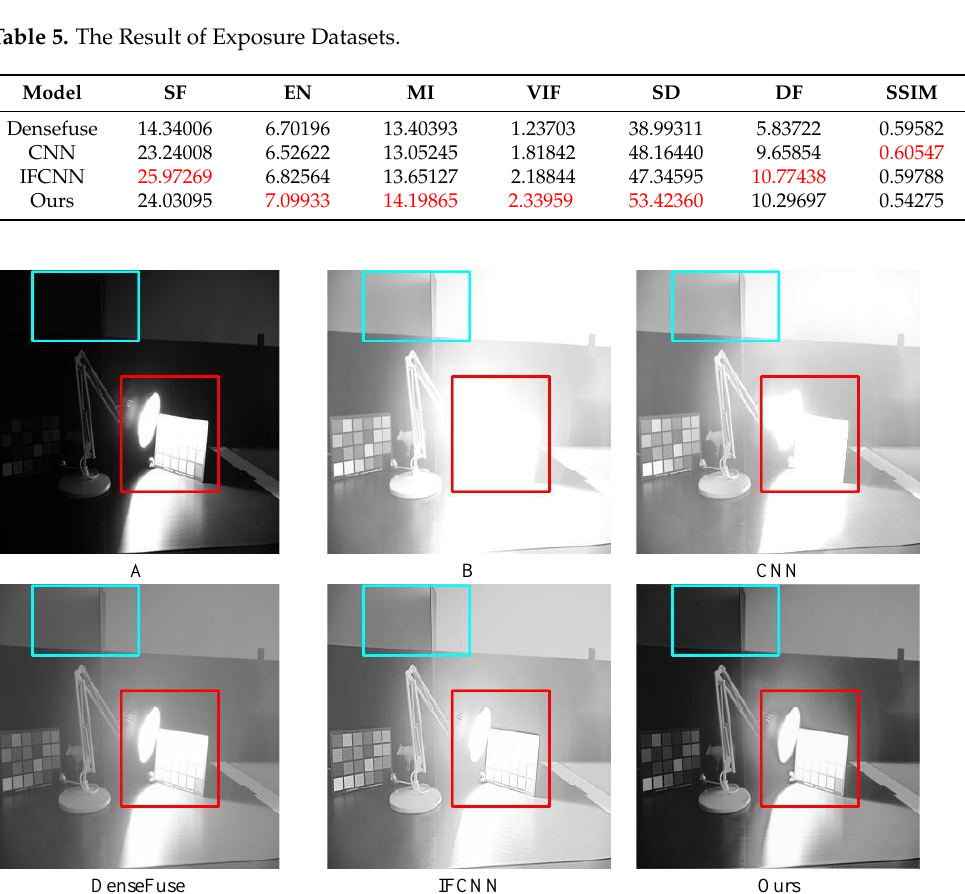
Figure 7. The Result of Exposure